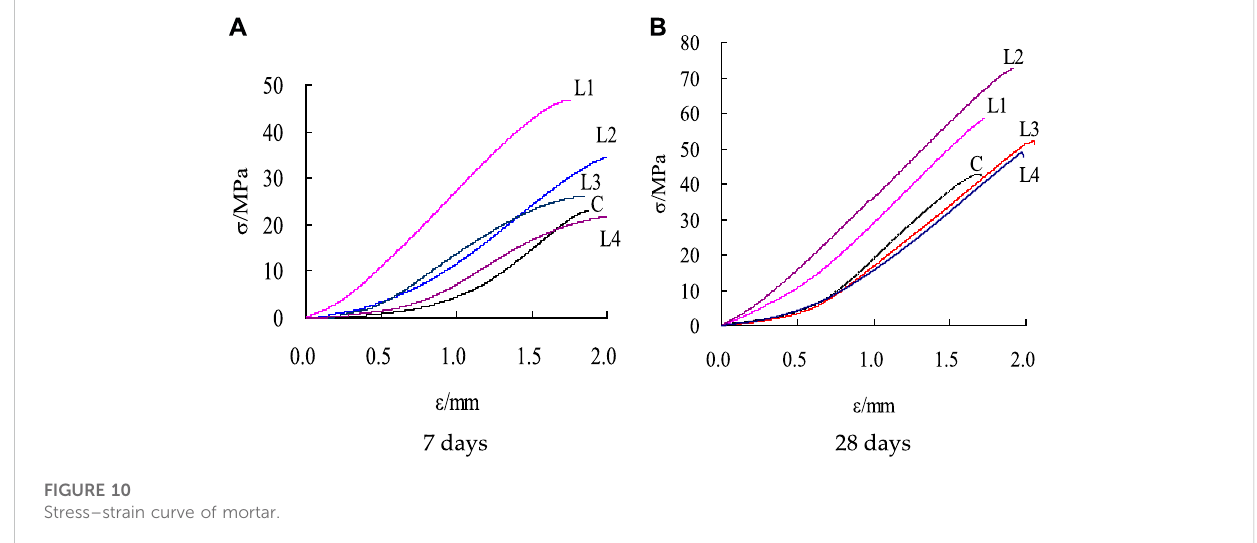
FIGURE 10 Stress – strain curve of